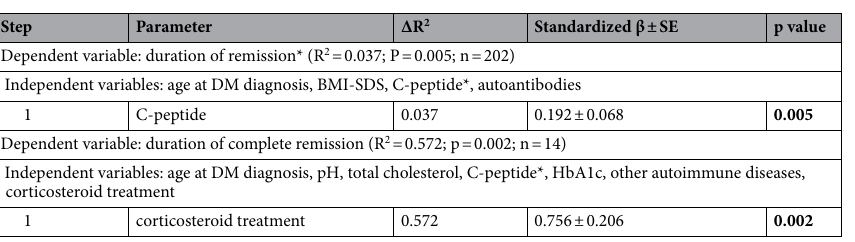
Table 3. Multiple forward linear regression of duration of remission, and complete remission as dependent variables. Analyzed in forward linear multiple regression analyses. DM diabetes mellitus, BMI body mass index, SDS standard deviation score. Significant values are given in bold. *Calculated with log transformed